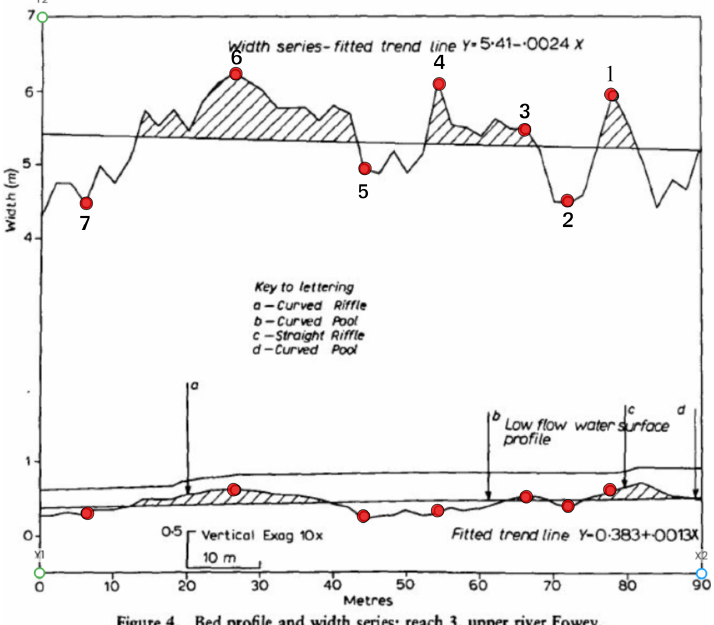
Figure B2. Modified Fig. 4 of Richards (1976) showing the locations of channel width and elevation profile measurements indicated by the open circles. The width series is at the top of the image and the elevation profile series is at the bottom. Values are in meters. Flow is right to left in the image.